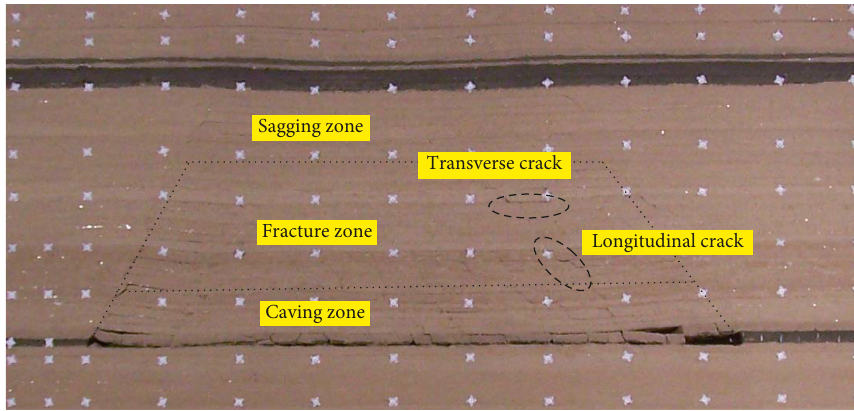
Figure 5: Three zones of overburden